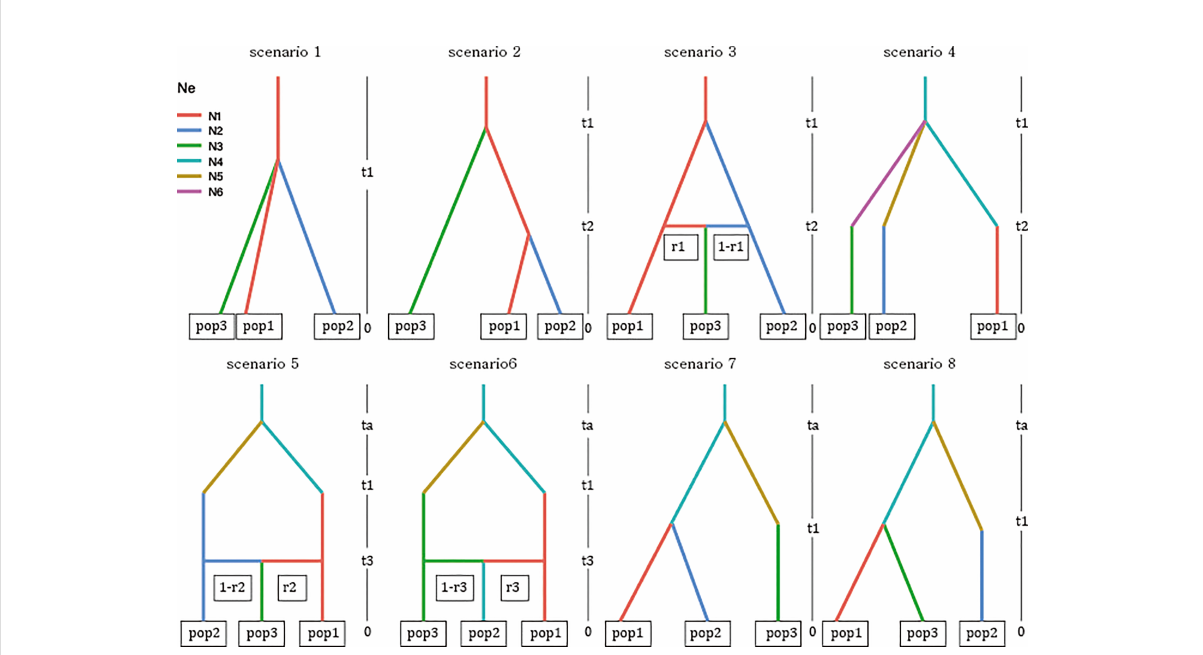
FIGURE 2 Graphical illustration of the eight scenarios of invasion history for burcucumber invasion in Korea competed on the approximate Bayesian computation analysis implemented in DIYABC-RF v. 1.0. See Table 1 for cluster information used in the analysis (pop1 – pop3). Acronyms: ta, time of divergence in the origin; t1, time of introduction; t2 and t3, time of divergence or admixture in the introduced region (Korea); r1 – r3, recombination rates; N1 – N3, effective population sizes of sampled populations; N4 – N6, effective population sizes of unsampled populations (ghost populations) from the